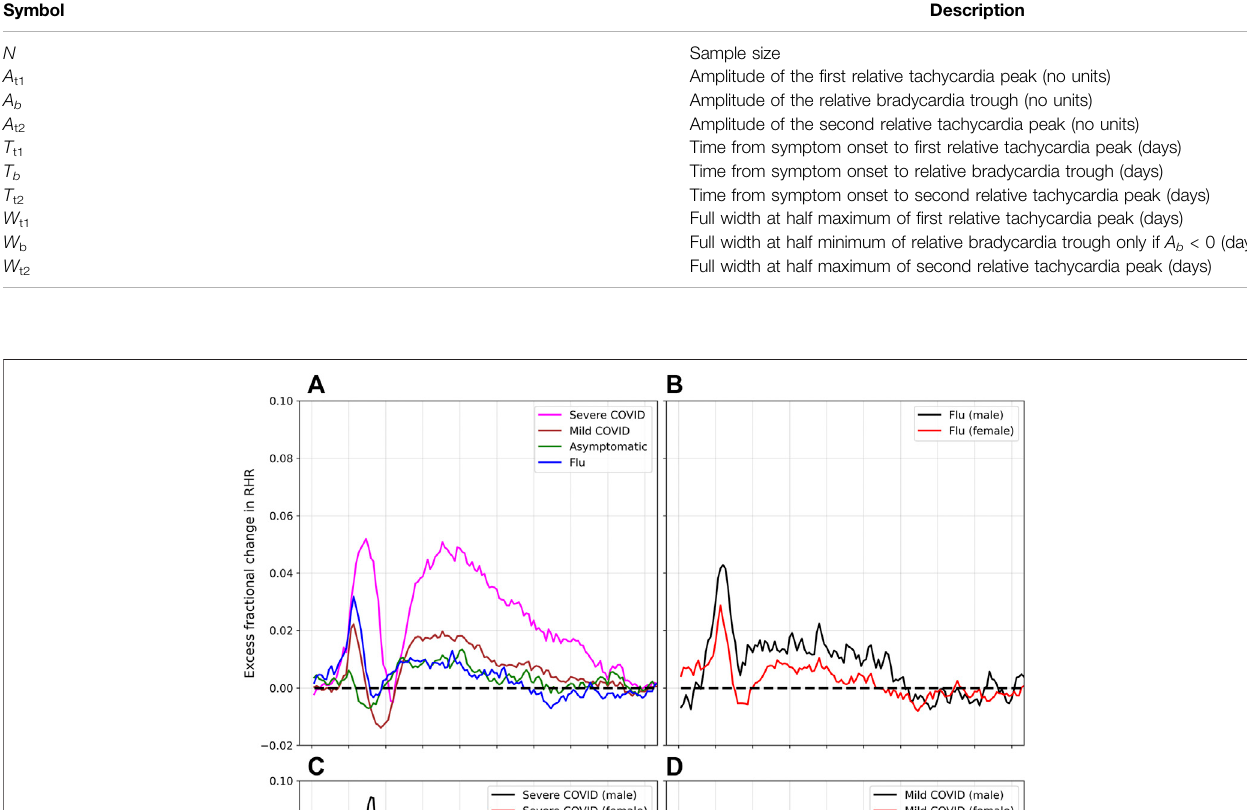
Frontiers in Physiology |